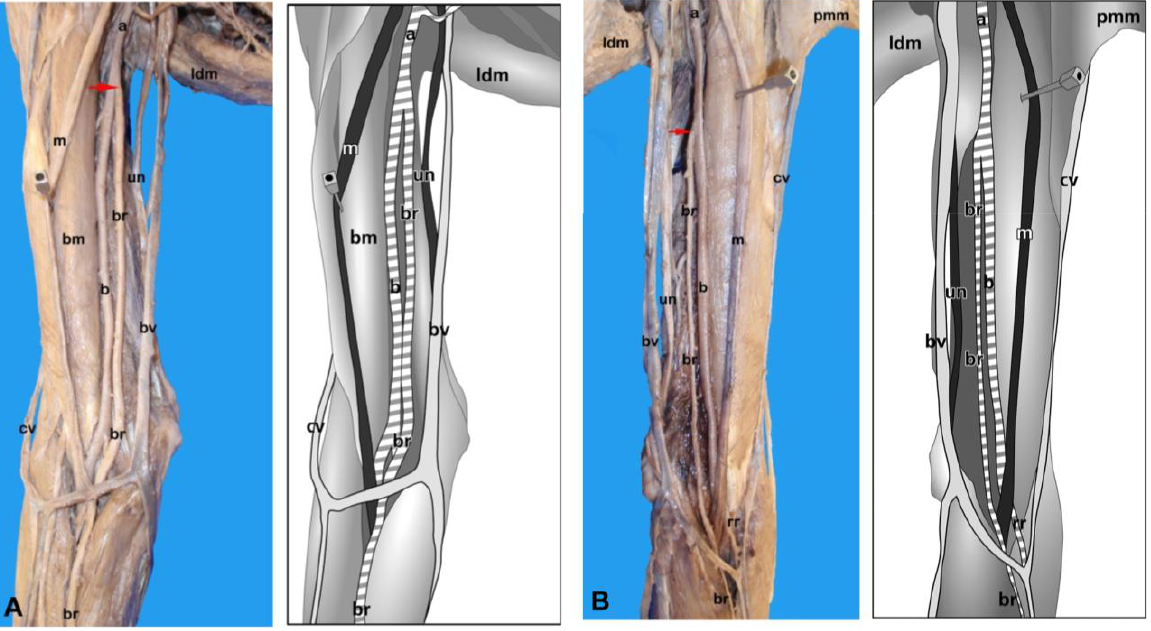
FIGURE 2. Anterior view of the arm and forearm of the female cadaver. A brachioradial artery is seen in both the right (A) and left (B) arm and forearm. The red arrow indicates the origin of the brachioradial artery in both panels. Abbreviations as in Fig. 1.